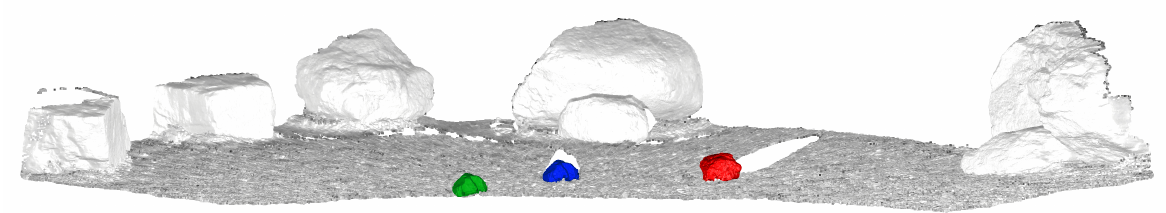
Figure 5. Point cloud of the geomonitoring scenery (first epoch). Stable natural environment is indicated by grey color (intensity). Rocks, which where placed in the scenery are displayed in color: stable rock (red), displaced rock (blue = first epoch, green = third